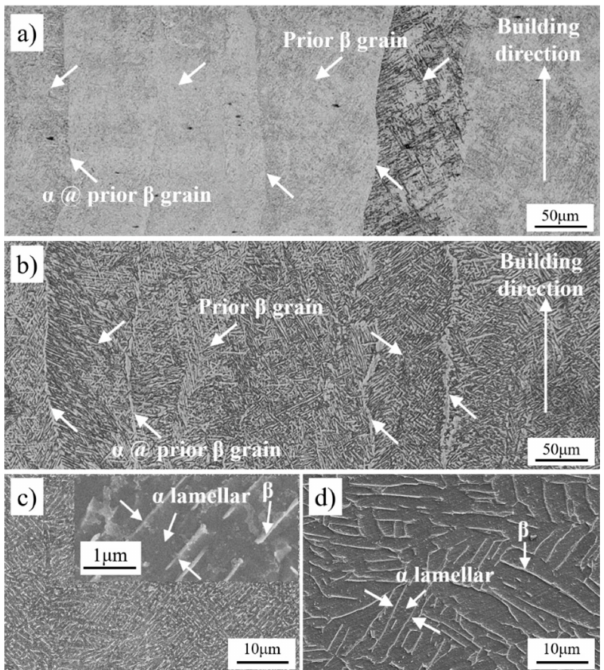
Figure 3. Microstructures of as-built and HIPed sample: ( a ) microstructures of longitudinal section of as-built sample; ( b ) microstructures of longitudinal section of HIPed sample; ( c ) microstructures of transversal section of as-built sample, the inset represent a magnified image; ( d ) microstructures of transversal section of HIPed sample.